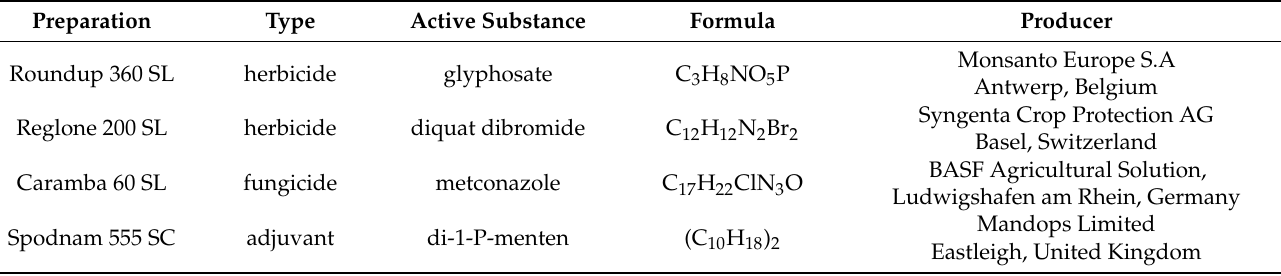
Table 2. Preparation